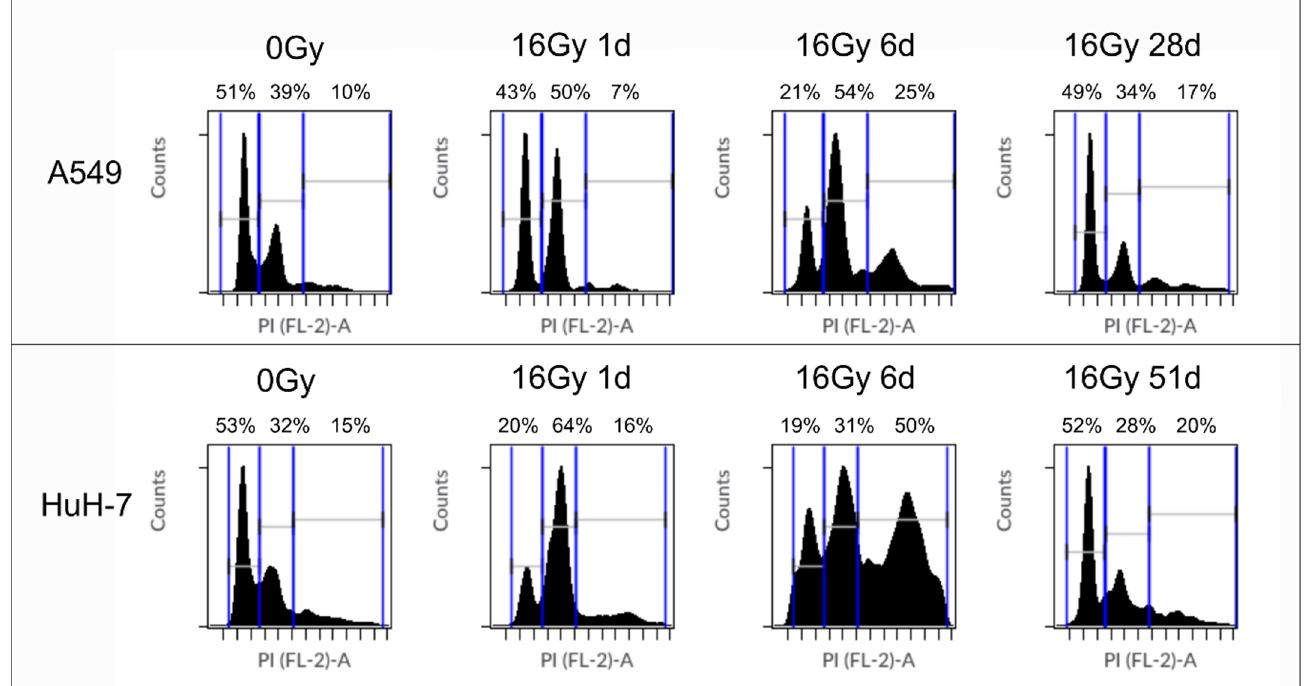
Figure 11. Cell cycle distribution of A549 and HuH-7 cells before irradiation, immediately after 16 Gy gamma-irradiation and after the appearance of a new population of non-senescent cells after 28 days (A549) and 51 days (HuH-7) after irradiation. The majority of the untreated A549 and HuH-7 cells was in the G1 phase. Between day one and six after irradiation with 16 Gy both cell lines entered G2 cell cycle arrest. After 28 or 51 days, respectively, the cell cycle distribution reversed, and most of the cells were in the G1 phase again. Two representative cell cycle measurements are shown. Above each figure, we noted the percentage of cells in the corresponding cell cycle phase: the first number indicates the percentage of cells in the G1 phase, the second the percentage of cells in the G2 phase, and the last number indicates the percentage of polyploid cells.